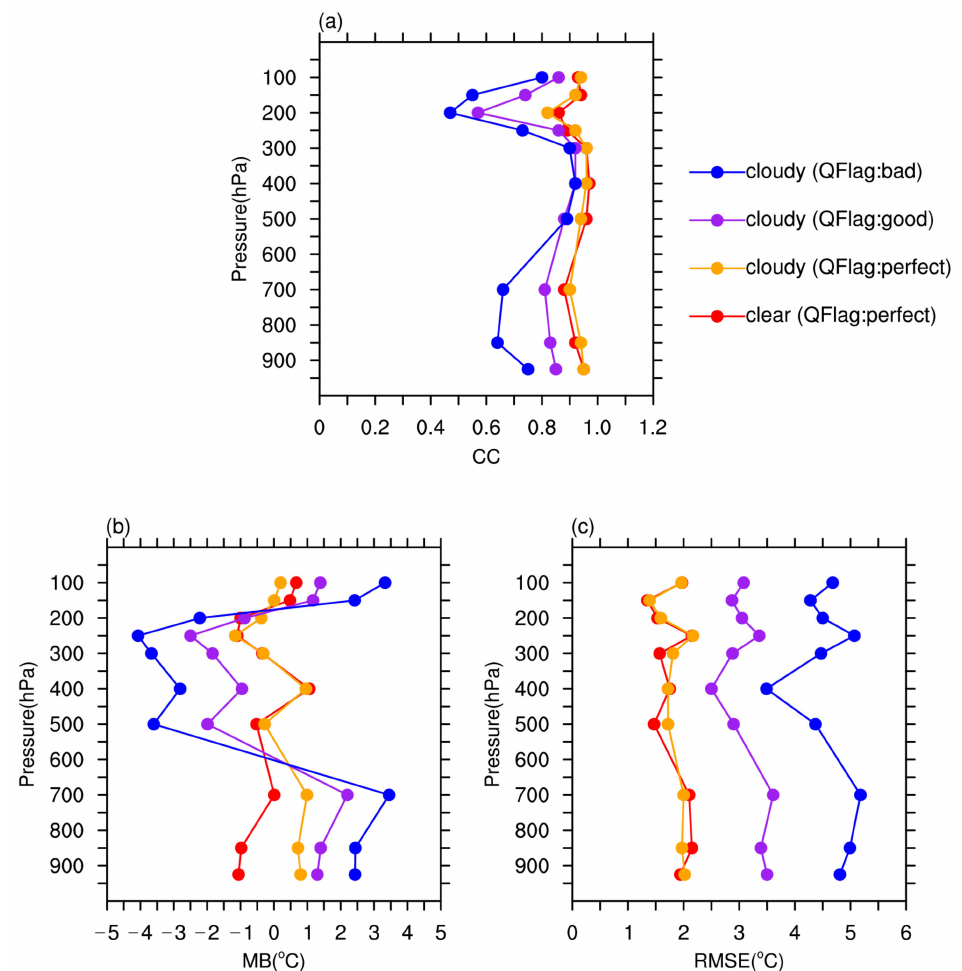
Figure 4. Statistical indicators of GIIRS atmospheric temperature profile products with respect to radiosonde observations in different pressure levels (100 hPa, 150 hPa, 200 hPa, 250 hPa, 300 hPa, 400 hPa, 500 hPa, 700 hPa, 850 hPa and 925 hPa). ( a ) Pearson correlation coefficient; ( b ) mean bias; ( c ) root mean square error. The four types of GIIRS data are the perfect flagged under the clear sky (red line), the perfect flagged under the cloudy sky (orange line), the good (purple line) and bad (blue line) flagged under the cloudy